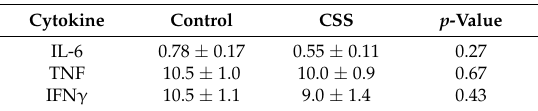
Table 2. Mean ± SEM basal plasma cytokine values from control and CSS F1 juvenile females with p -value results from 2-tailed t